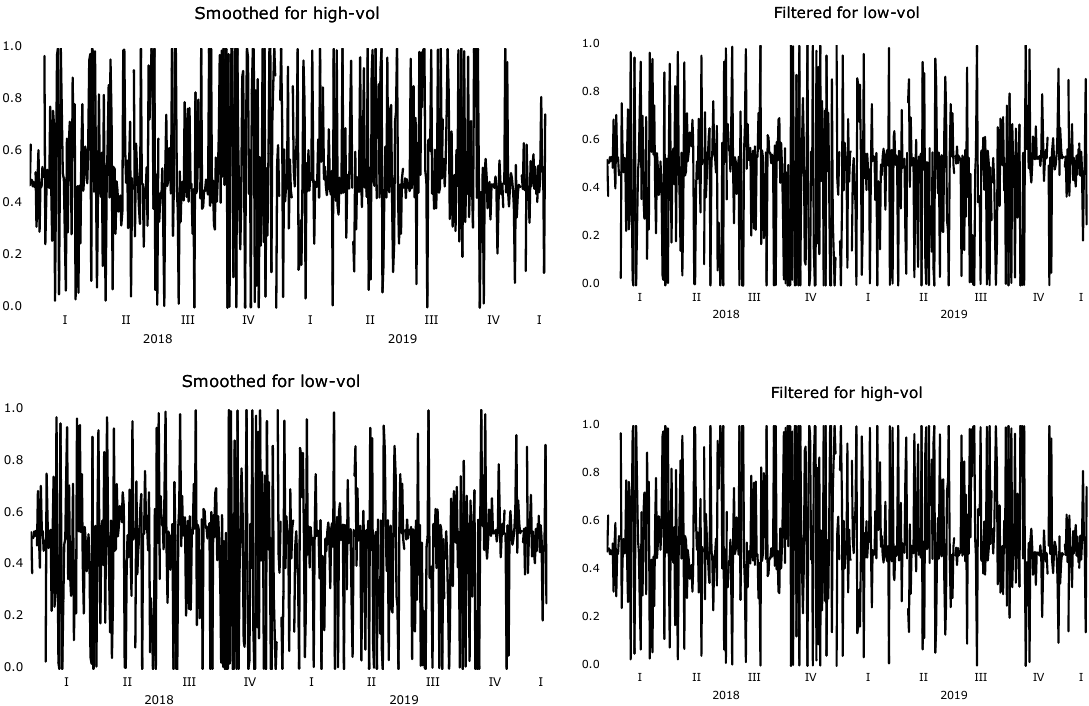
Figure 7. Computed smoothed probabilities and filtered conditional volatilities for IGV.